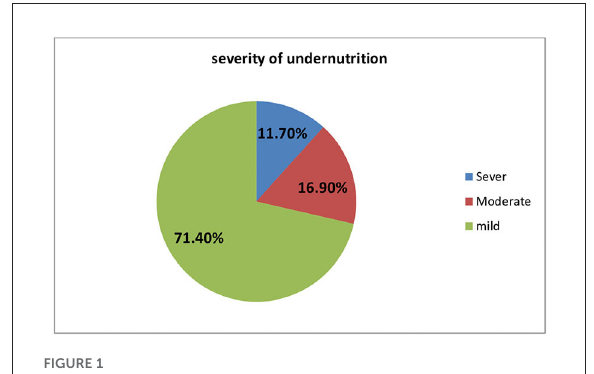
FIGURE1 Severity of undernutrition in the study participants at Bench Maji Zone.